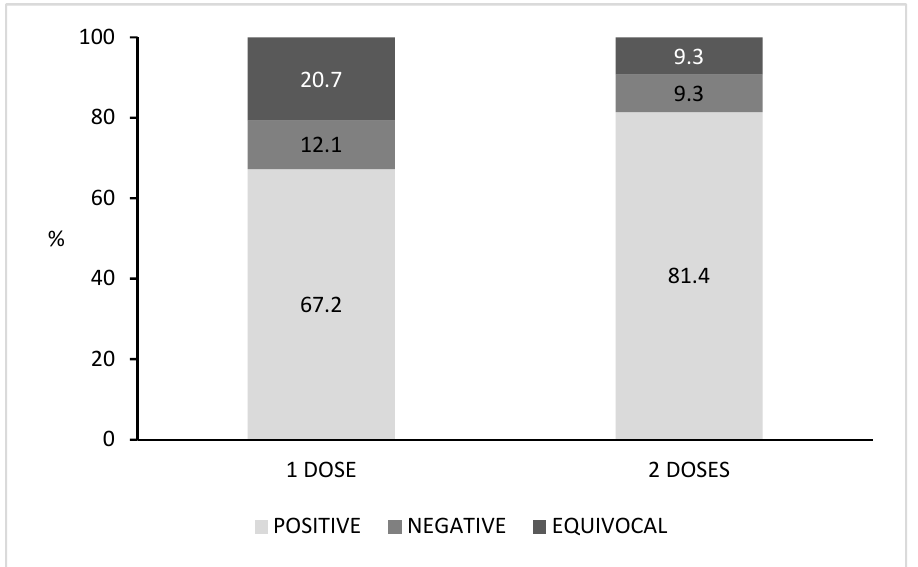
Figure 2. Percentage distribution of positive, negative and equivocal subjects according to the number of vaccine doses received.